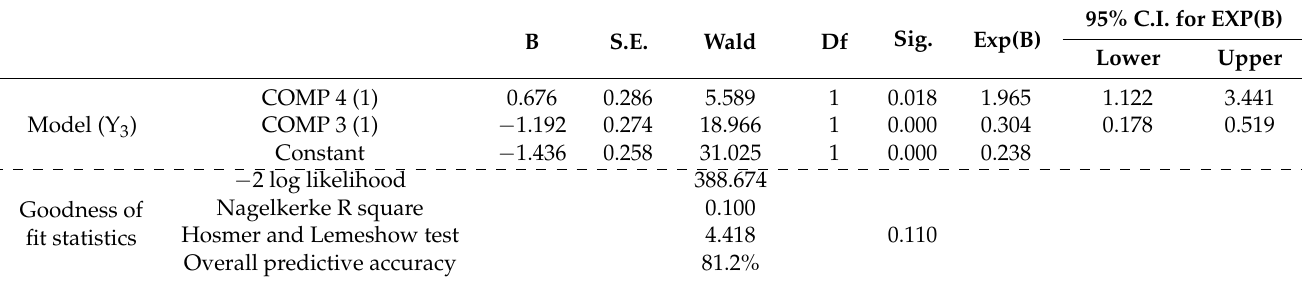
Table 10. Multivariate regression results between disruption in water supply and predictor variables.